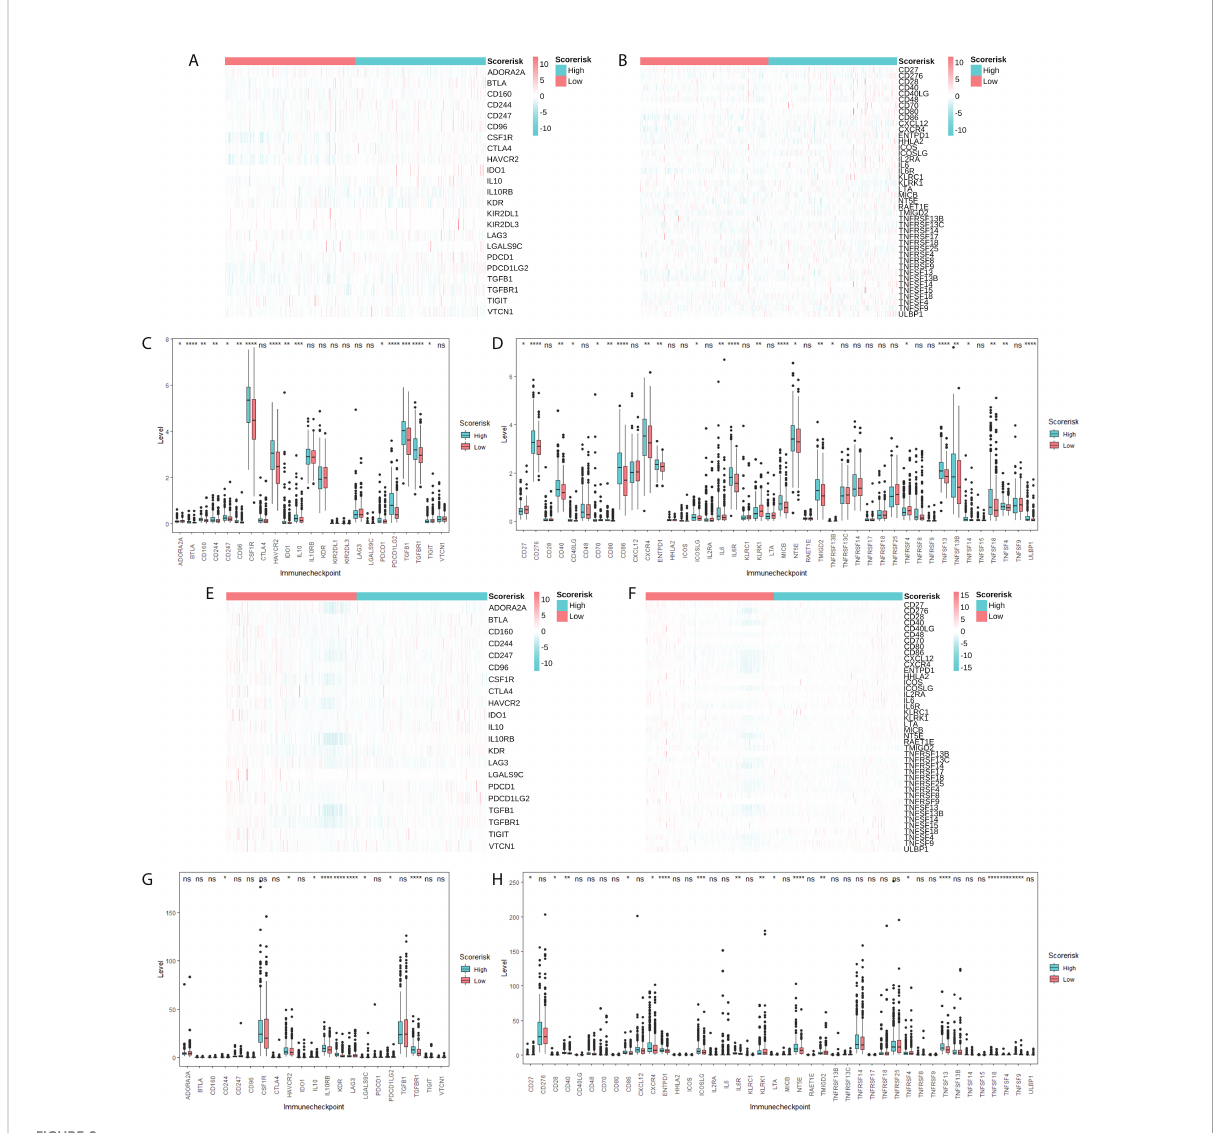
FIGURE 8 Association between CARS and immune checkpoint molecules. Heatmap (A) and difference analysis (C) of immunoinhibitor related molecules among low- and high-risk groups in TCGA cohorts. Heatmap (B) and difference analysis (D) of immunostimulator related molecules among low- and high-risk groups in TCGA cohorts. Heatmap (E) and difference analysis (G) of immunoinhibitor related molecules among low- and high-risk groups in CGGA cohorts. Heatmap (F) and difference analysis (H) of immunostimulator related molecules among low- and high-risk groups in CGGA cohorts. ns, not signi fi cant; * P < 0.05; ** P < 0.01; *** P < 0.001; **** P <